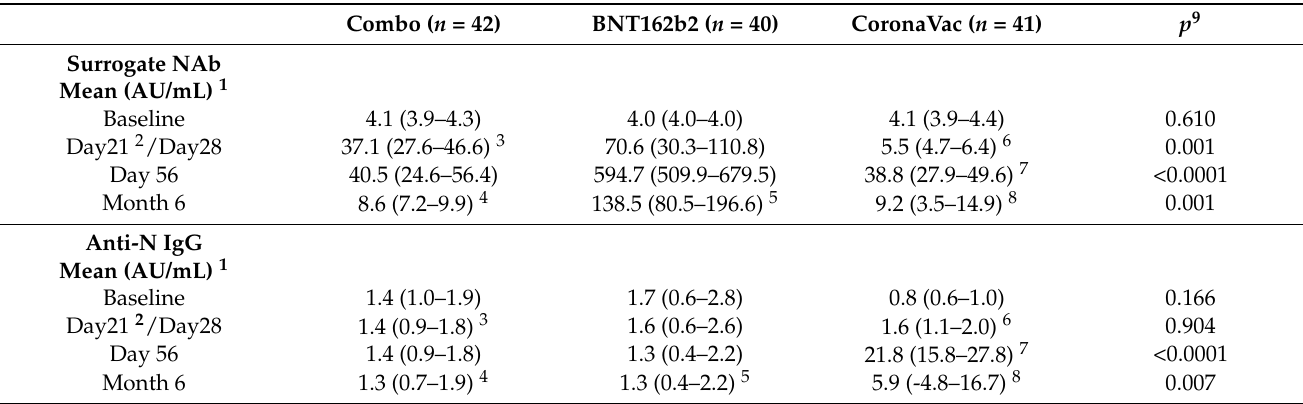
Table 3. Surrogate NAb and anti-N IgG.